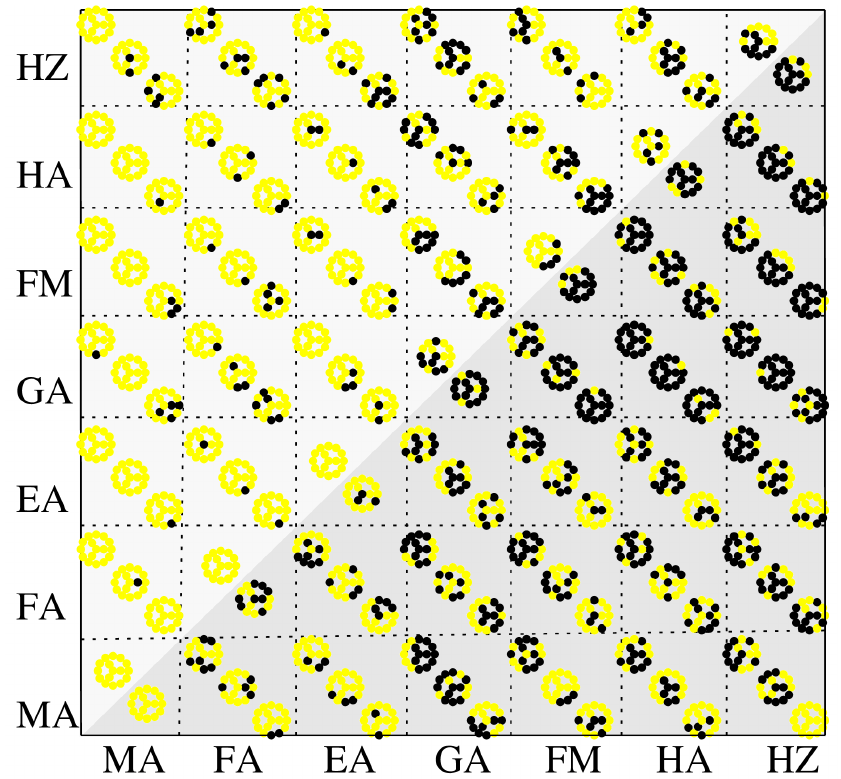
Figure 3. Classification of 3D perovskite structures of formula A x A’ 1 − x PbX y X’ z X” 3 − y − z based on Pb- X bond length statistics: feasible (yellow dots) and likely infeasible (black dots) 3D structures. A and A’ index the rows and columns, respectively. Each matrix element, except the ones on the secondary diagonal, has the representation given in Figure 1b. Two criteria have been considered (marked by shaded areas): f bl = 10% deviations (upper left triangle) and f bl = 5% deviations (lower right triangle) from the smallest or the largest Pb-X bond lengths as established for MAPbX 3